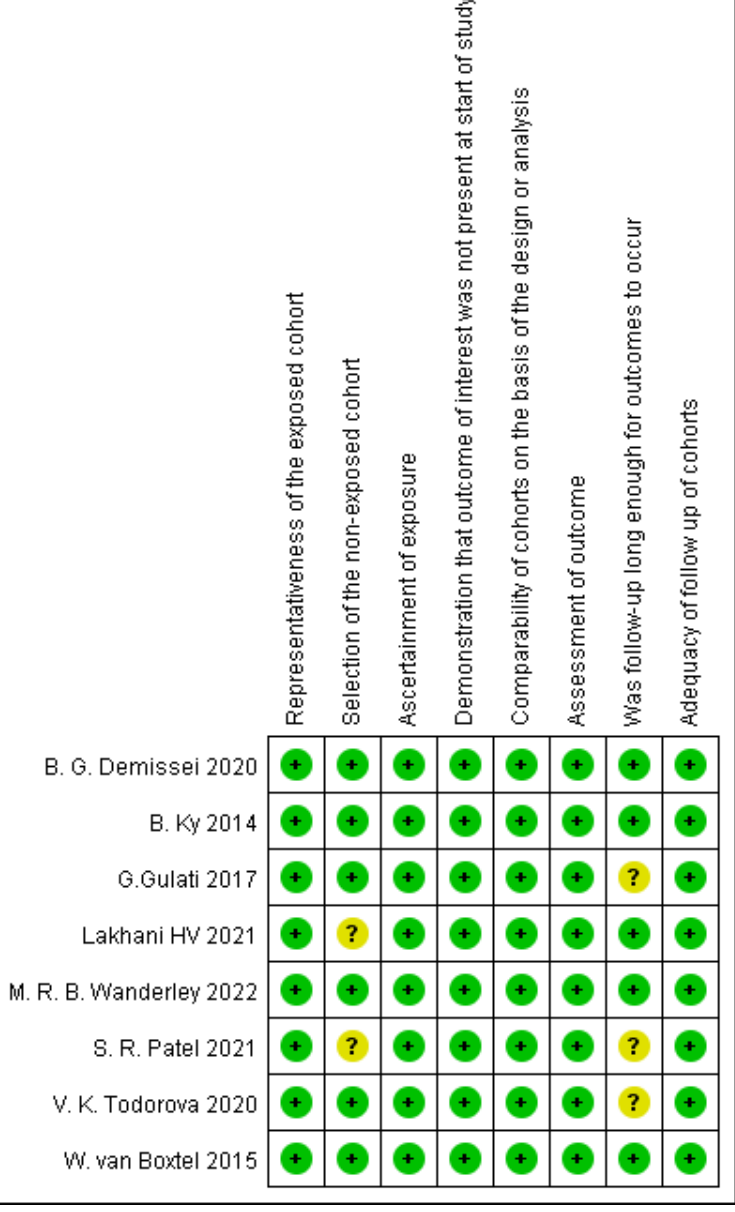
Figure 2. Quality assessment using the Newcastle-Ottawa Scale for cohort studies [13–20].